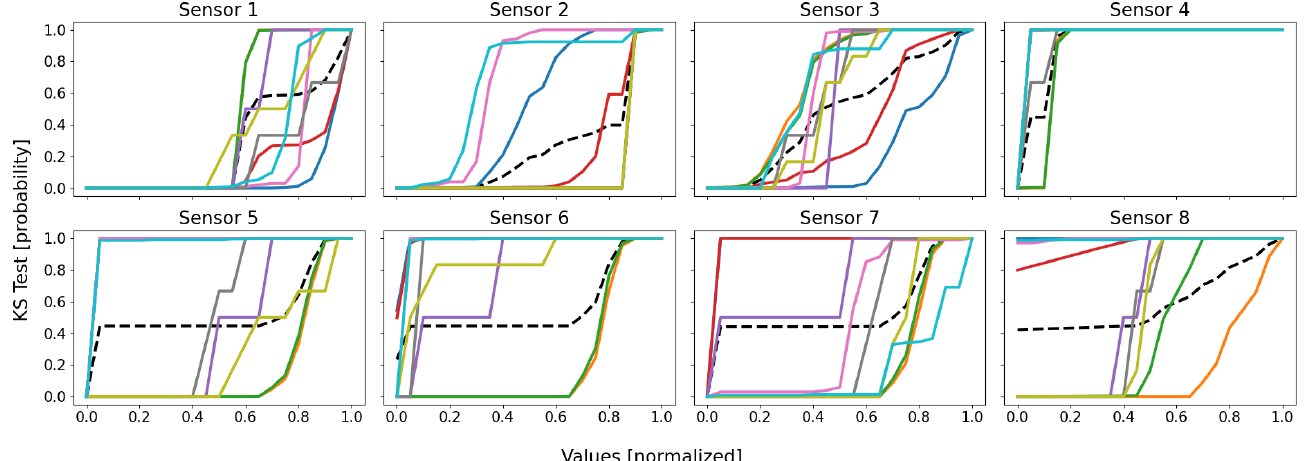
Figure 5. Battery 1 probability distributions. The solid colored lines are the empirical distributions of each cluster, and the black dashed line is that of the database D 1 . The abscissa shows the real normalized values of the corresponding sensor, and the ordinates, their probabilities of appearance.